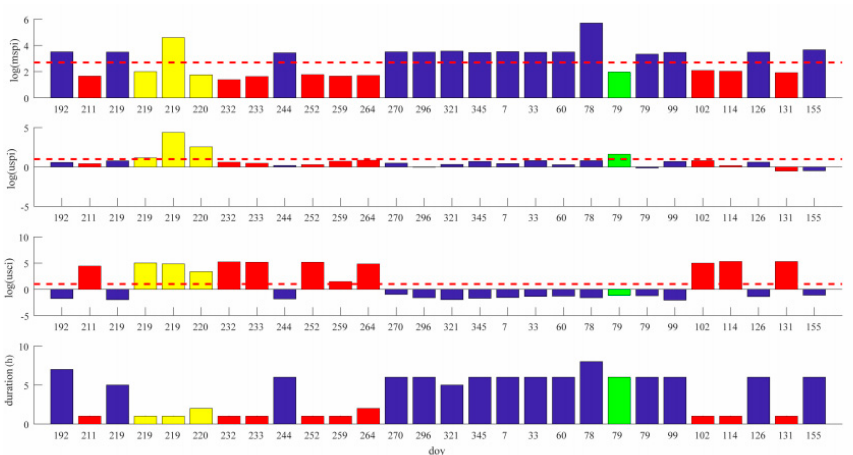
Figure 3. Unhealthy state statistics of C03. The subfigures correspond to mspi, uspi, usci, and duration of the unhealthy states, respectively. Blue bars represent Type 1 unhealthy states. Green bars represent Type 2 unhealthy states. Red bars represent Type 3 unhealthy states. Yellow bars represent Type 4 unhealthy states.